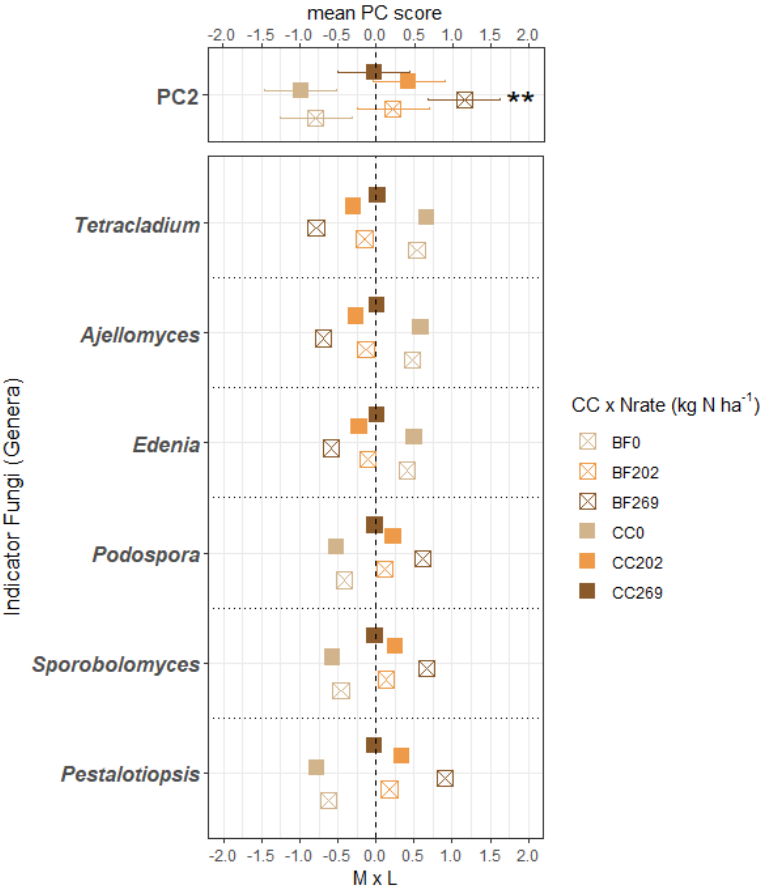
Figure 6. The top panel shows the estimated mean principal component (PC) scores of the fungal PC2 for each level of N rate and cover cropping (CC × Nrate) treatment interaction with their standard errors of the mean as whiskers. The asterisks indicate the probability value of the treatment effect from analysis of variance (**: p < 0.05). The bottom panel shows the contribution of each fungal indicator to PC2 multiplied by the mean PC scores of each level of N rate and cover cropping treatment interaction (M × L). The N rate treatment levels are: 0 kg N ha − 1 (tan), 202 kg N ha − 1 (orange), and 269 kg N ha − 1 (brown). The cover cropping treatment levels are bare fallow (BF; crossed box) and cover crop mixture (CC; filled